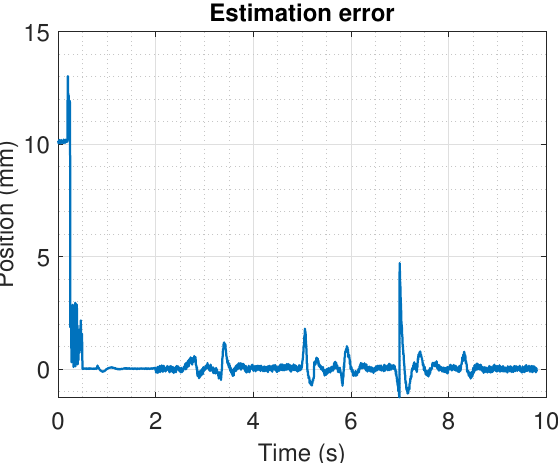
Figure 18. Comparison error between the estimated position and a direct measurement obtained with a linear movement